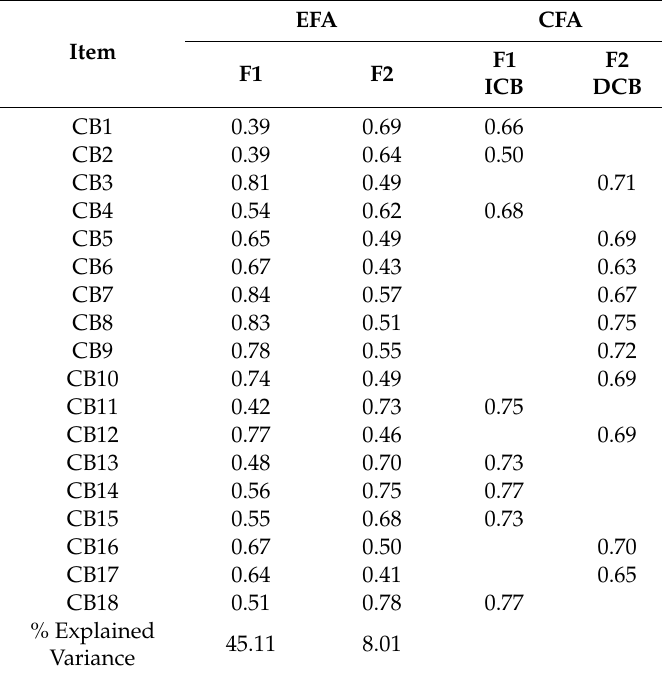
Table 2. Factor loadings for the EFA and